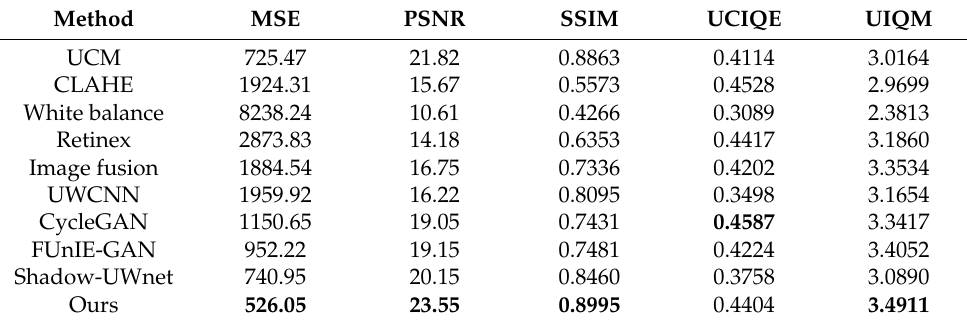
Table 2. Quantitative evaluation results of several algorithms (best scores are